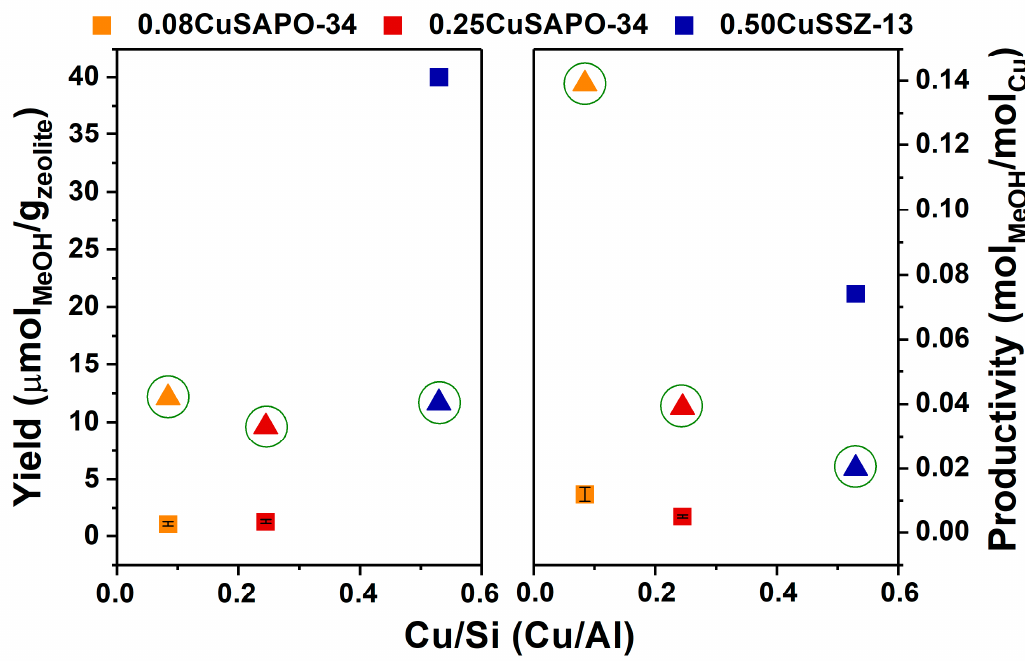
Figure 9. Comparison of the standard test conditions (Test #1-represented by squares) to the high temperature CH 4 -loading test conditions (Test #2-represented by green circled triangles). The panel on the left shows CH 3 OH yield per gram of zeolite. The panel on the right gives the CH 3 OH yield normalized to the Cu content (mol CH3OH / mol Cu ). Colours: 0.08CuSAPO-34 (orange), 0.25CuSAPO-34 (red) and 0.50CuSSZ-13 (blue). The estimated error from DMTM conversion over the Cu-SAPO-34 materials in Test #1 is shown as black error bars inside the squares.